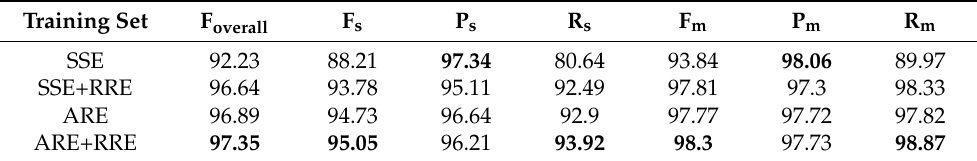
Table 4. This evaluation of precision, recall, and F-measure for speech and music was conducted on our in-house test set. It compares our model trained on different training sets. The bold values indicate the largest number in each